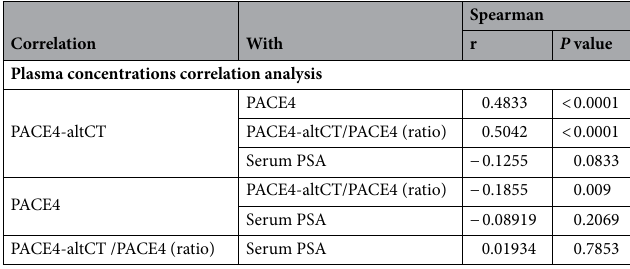
Table 2. Correlation analysis between plasmatic